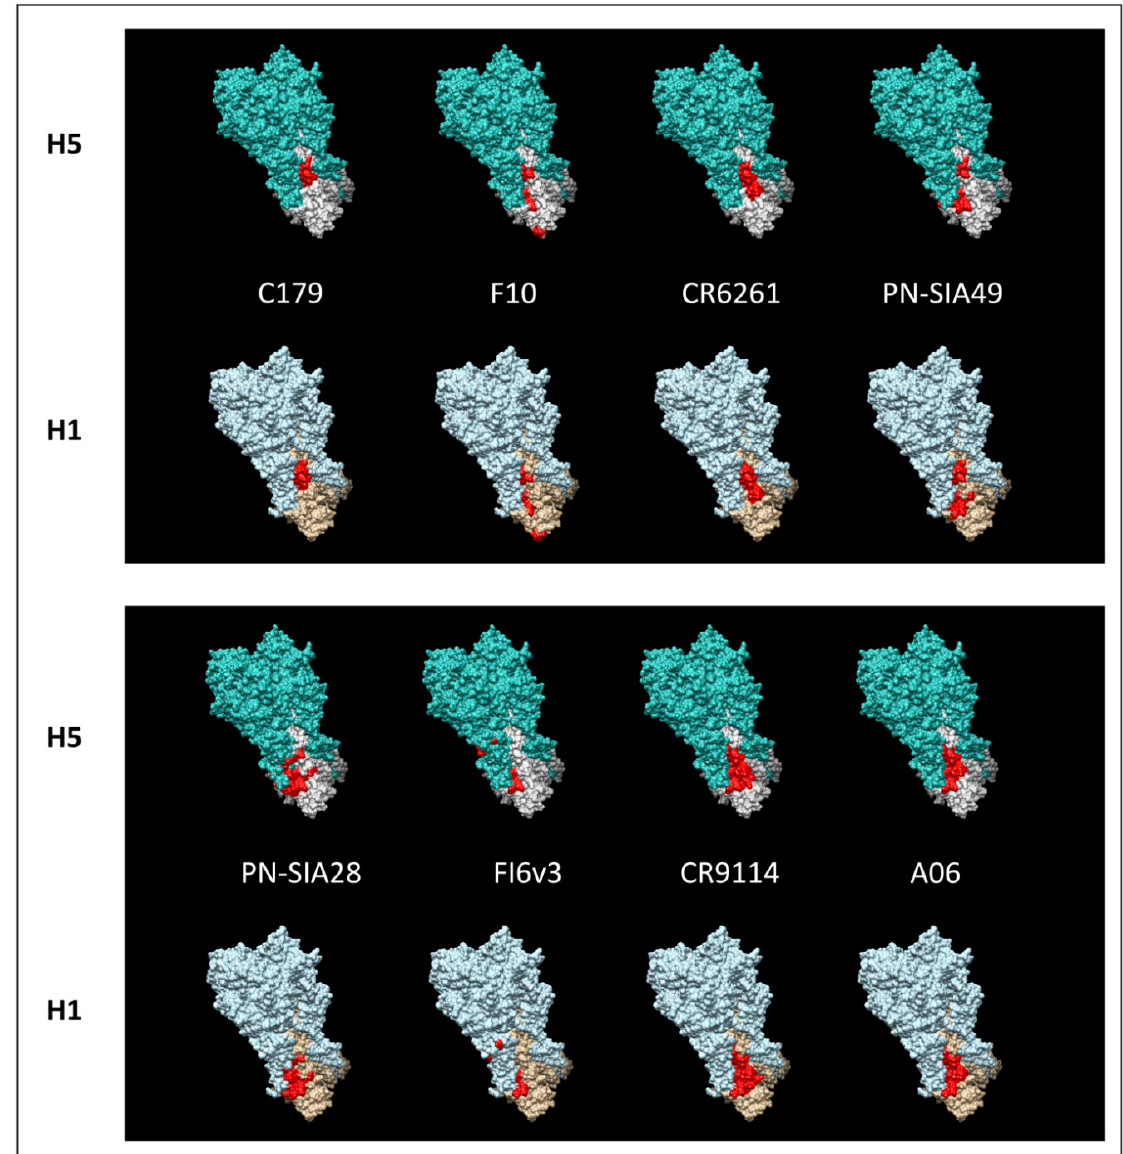
Figure 1. Mapping of the different B-cell epitopes (red) on the crystal structures of trimeric HAs belonging to H5 and H1 subtypes (pdb id number 2FK0 and 1RU7). HA1 and HA2 are depicted respectively in light green and white for H5 subtype and light blue and beige for H1